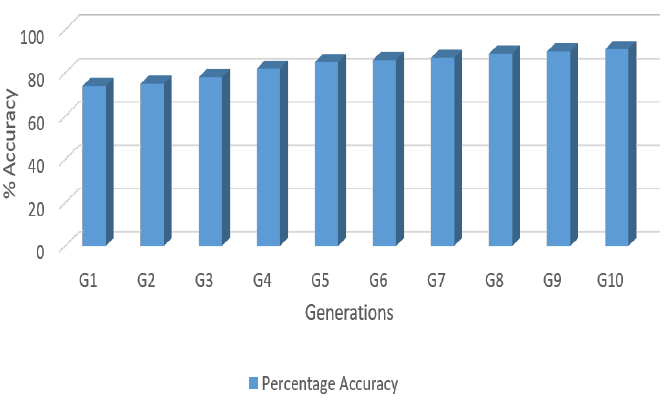
Figure 6. Average accuracy score of the GALSTM-FDP model across 10 generations.